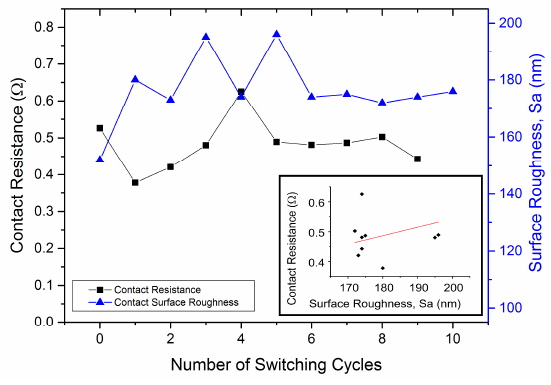
Figure 7. The evolution of contact resistance and surface roughness over 10 cold switching cycles.